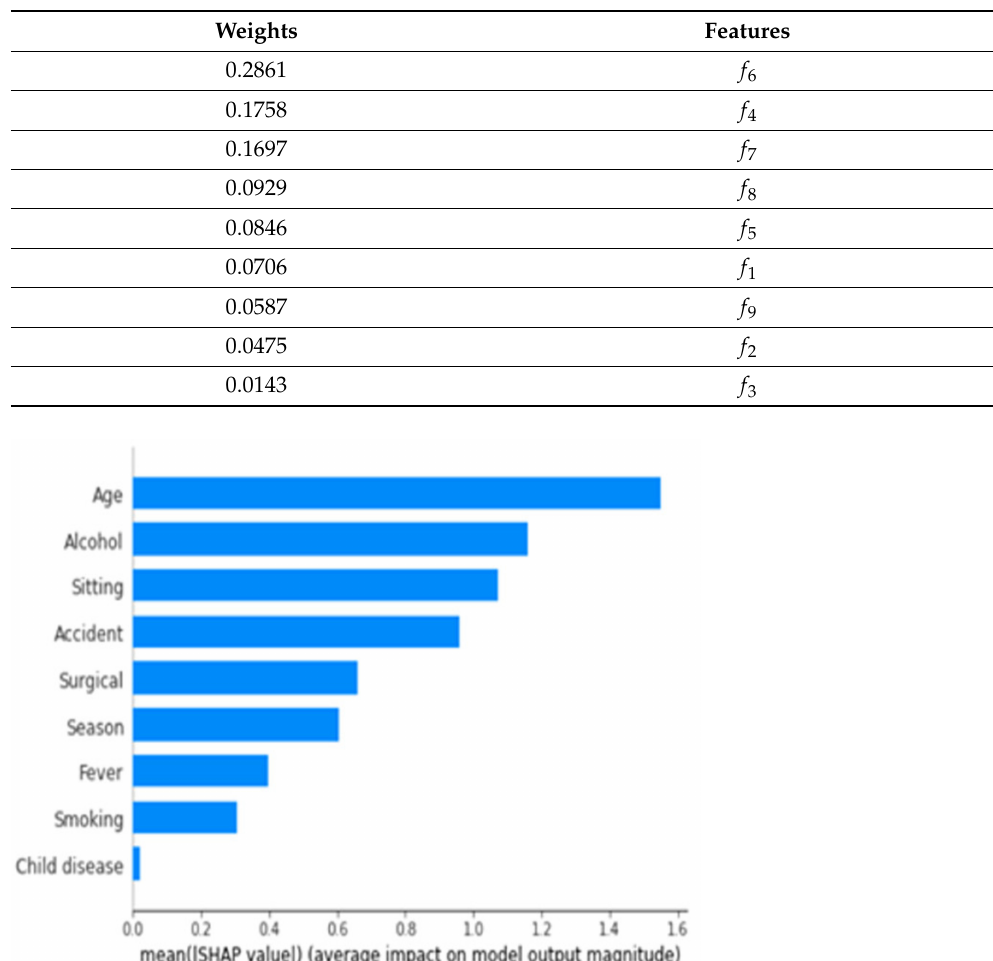
Table 6. Feature weights and their impact on the proposed model.